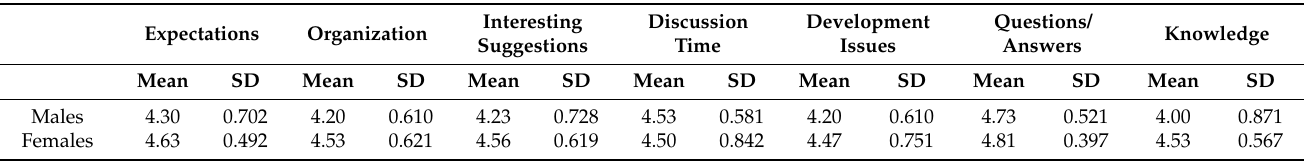
Table 5, and (c) for experiments (level of study/place of conduct of the interactive teaching) in Table 6. Table 4. Mean values and standard deviations of “acquired knowledge organization” questions in relation to gender of budding journalists.